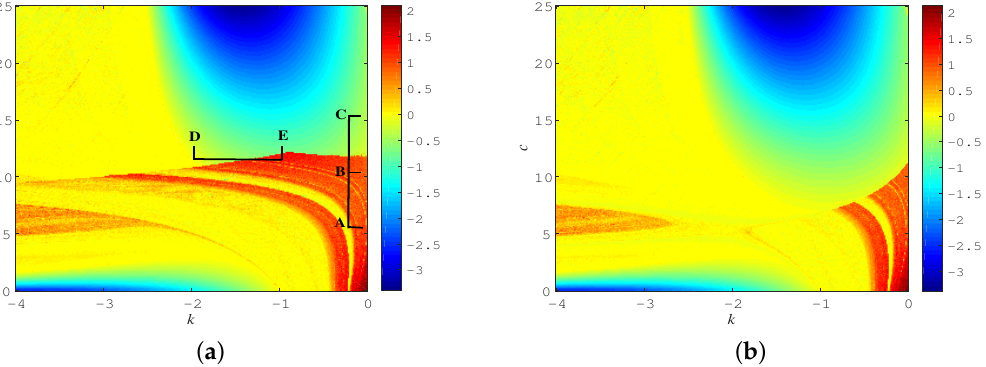
Figure 12. Division of parameters k and c with different initial conditions: ( a ) ( x 0 , y 0 , z 0 ) = ( 1,1,1 ) ; ( b ) ( x 0 , y 0 , z 0 ) = ( 1,10,1 )